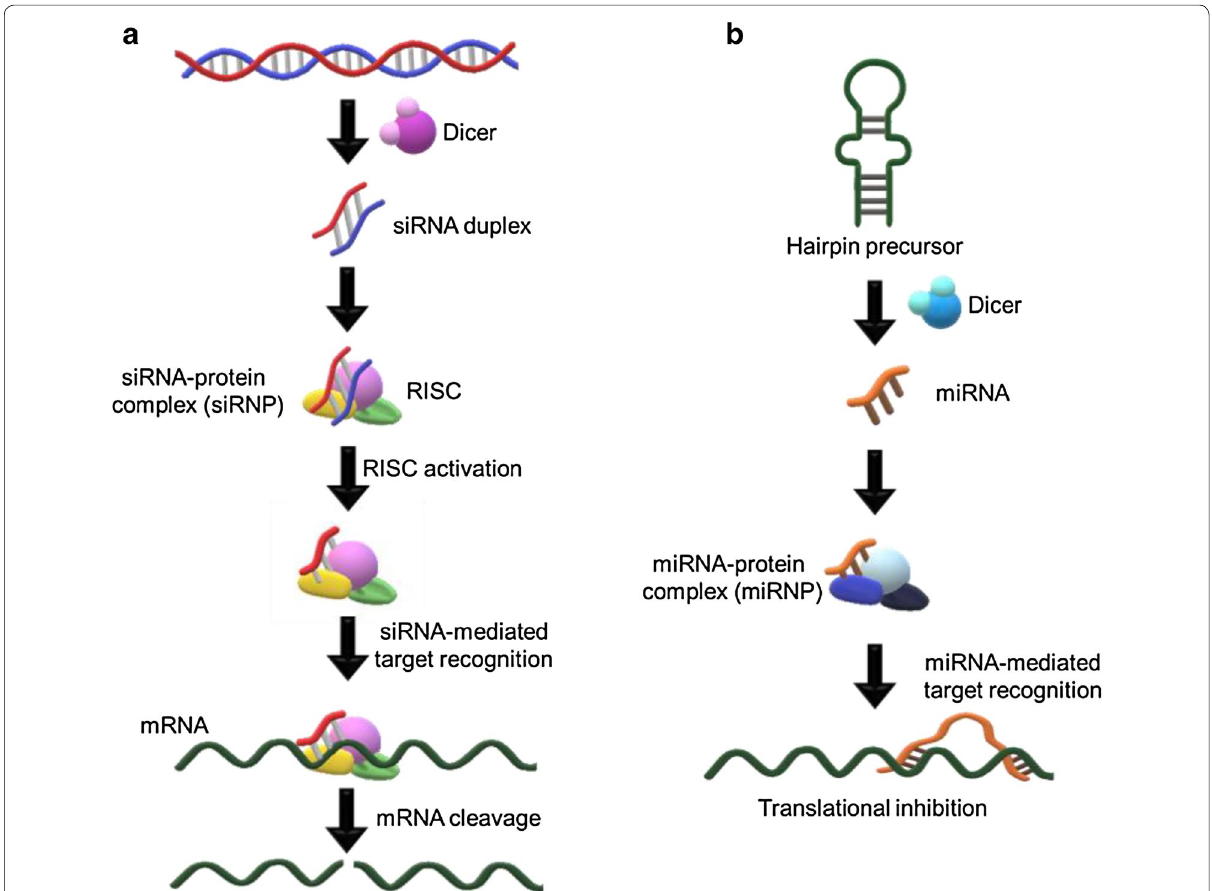
Fig. 1 Schematic drawing showing the mechanism of RNAi-based gene regulation: a siRNA pathway; b miRNA